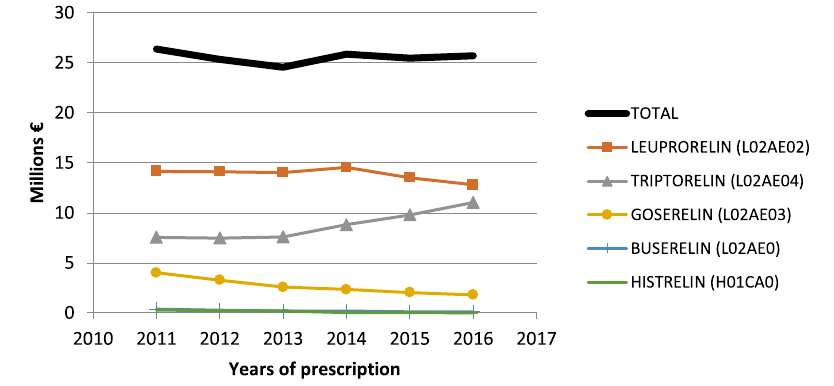
Figure 5. Total cost of LHRH analogues per year from 2011 to 2016 in